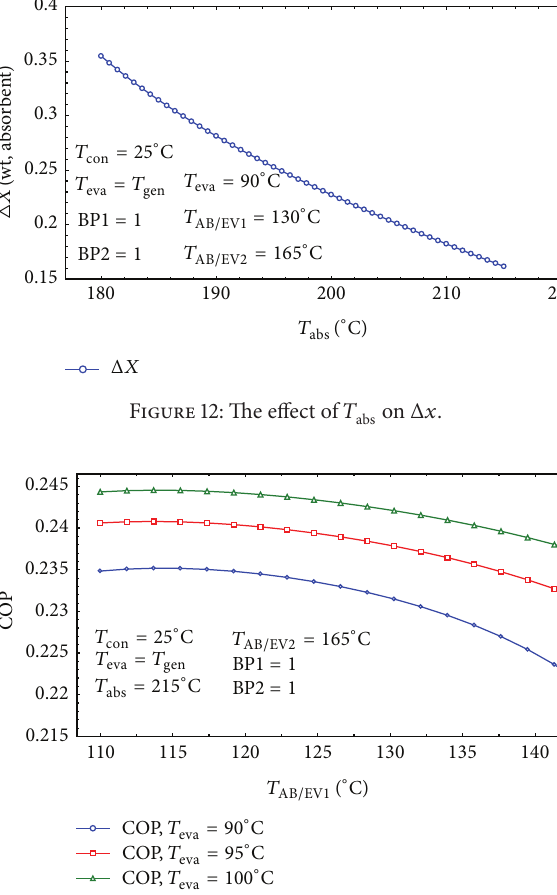
Figure 13: The effect of 𝑇